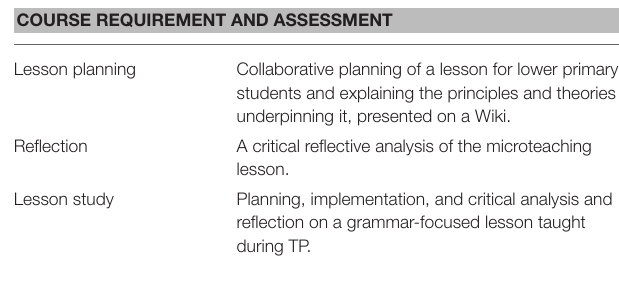
TABLE 5 | Overview of assessment tasks in Megan’s